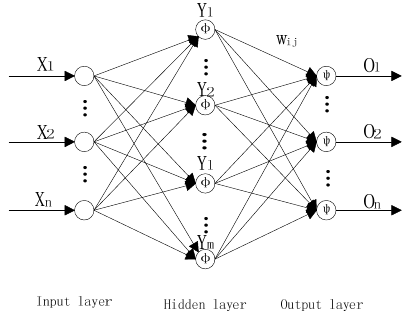
Figure 2. RBF neural network training model.